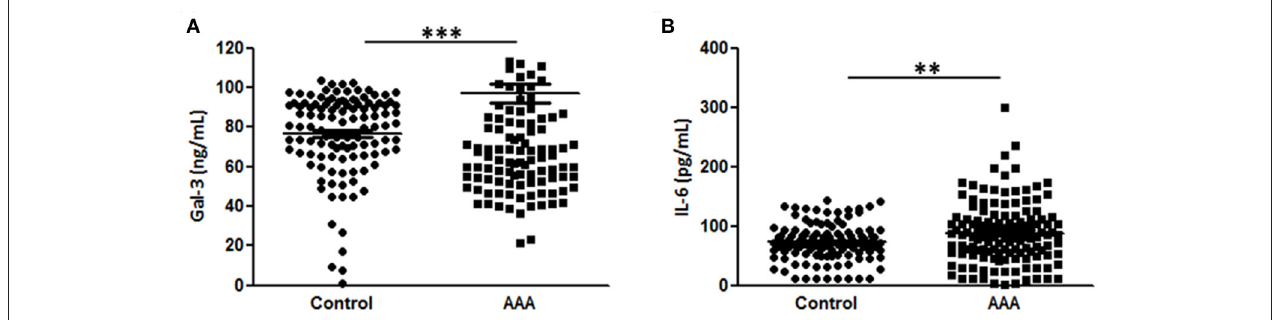
FIGURE 1 | Diagnostic value of Gal-3 and IL-6. (A) Gal-3 and (B) IL-6 concentrations in plasma samples from patients with AAA (n = 151) and control patients (n = 195). Data are expressed as mean ± standard error of the mean. ** p < 0.001, *** p < 0.001.